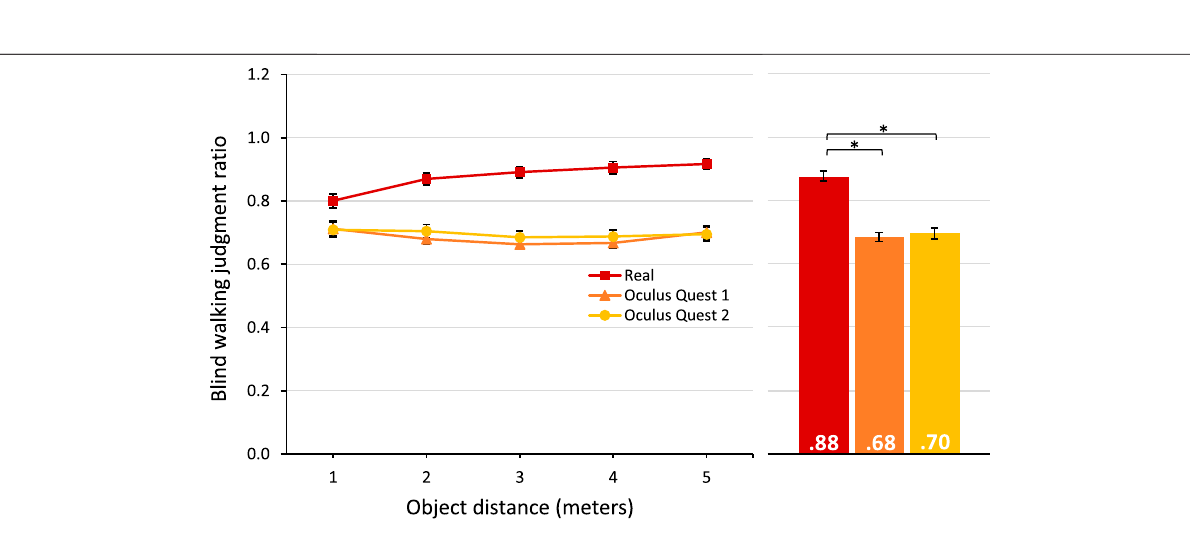
Frontiers in Virtual Reality |